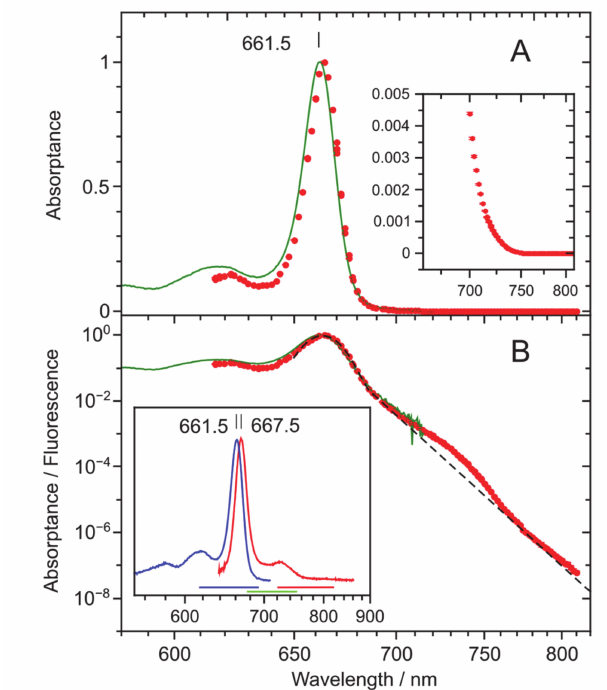
Figure 1. The normalized Q y absorptance (dark green solid line) and fluorescence excitation (red symbols) spectra of Chl a in TEA measured at ambient temperature of 22 ± 1 ◦ C (295 ± 1K). The signal intensity scale is linear in part Figure 1A and logarithmic in part Figure 1B to emphasize the peak and tail regions of the spectra, respectively. Note also that here and henceforth, a reciprocal (linear in energy) wavelength scale is used. Shown also in Figure 1A is the 200-fold amplified red part of the spectrum and in panel B, an approximate partition of the Q y bandshape into Gaussian origin and quasi-exponentially decaying tail parts (dashed black line). The insert of Figure 1B shows the conventional absorption (blue) and fluorescence (red) spectra of Chl a in the same solvent. Horizontal colored lines indicate the excitation ranges in red, blue, and intermediate (green) spectral regions, while the filtered fluorescence is registered over complementary ranges (see Materials and